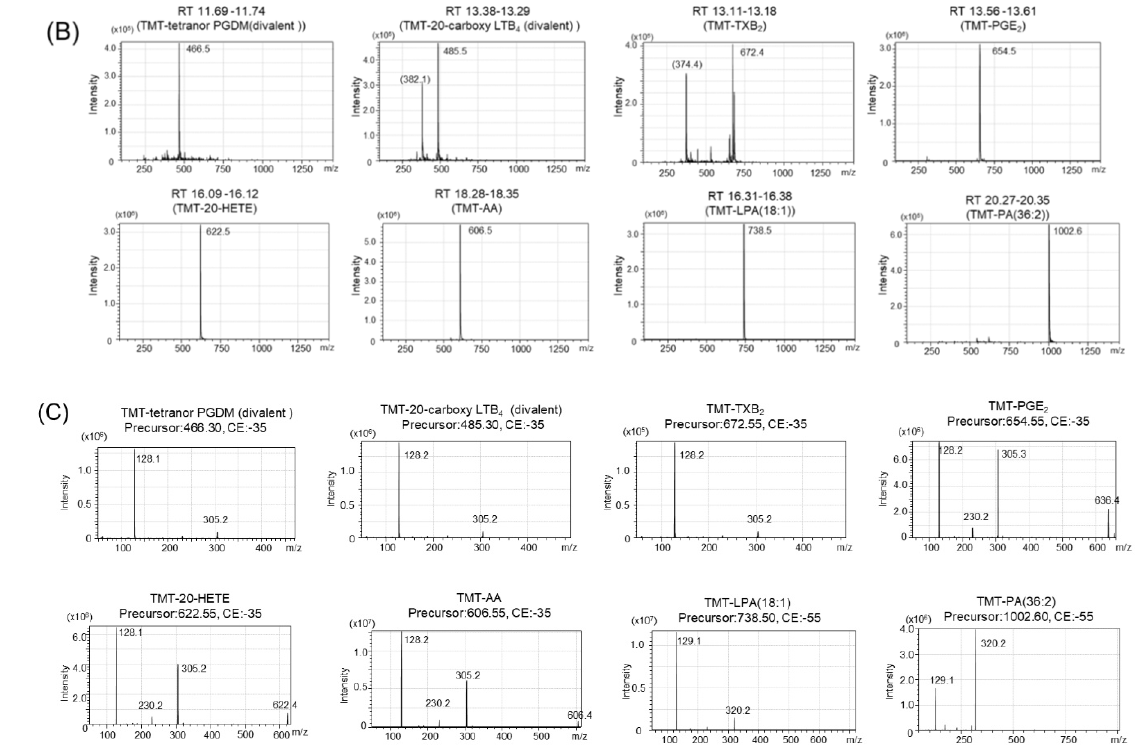
Figure 3. Derivatization of eicosanoids, fatty acids, lysophosphatidic acid and diacylphosphatidic acid. ( A ) Examples of chromatograms for input standards before (upper) and after (lower) derivatization with serum. Input signal compounds without derivatization was almost undetectable after derivatization. Selective reaction monitoring (SRM) transitions were shown at the top in each chromatogram as Q1 > Q3 (polarity). Injection volume was 5 µ L and the concentration of compounds were 0.85 ng/ µ L each for all targets except for LPA (18:1) at 17 ng/ µ L and PA (36:2) at 2 ng/ µ L. ( B ) Representative precursor ion mass spectra obtained by tandem mass tag (TMT) reporter ion-specific precursor ion scanning analysis. Injection volume was 5 µ L and the concentration of standards for derivatization was 42.5 pg / µ L each for all targets except for LPA(18:1) at 17 ng/ µ L and PA(36:2) at 2 ng/ µ L. Eicosanoids and AA was derivatized with aminoxy TMT-128 and precursor ion scanning for 128.15 was performed. LPA (18:1) and PA (36:2) was derivatized with aminoxy TMT-129 and